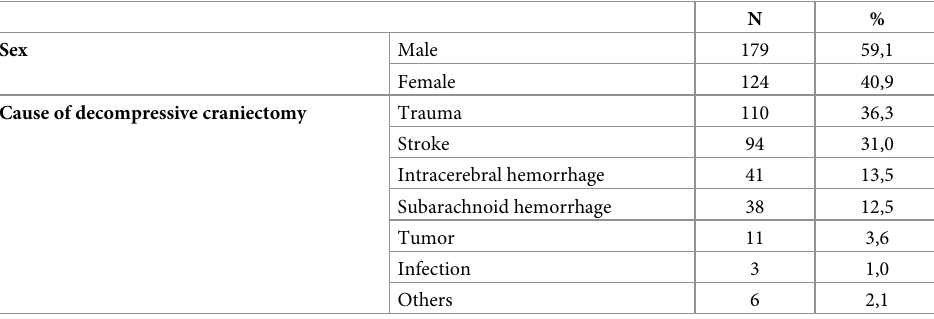
Table 1. Gender and cause of decompressive